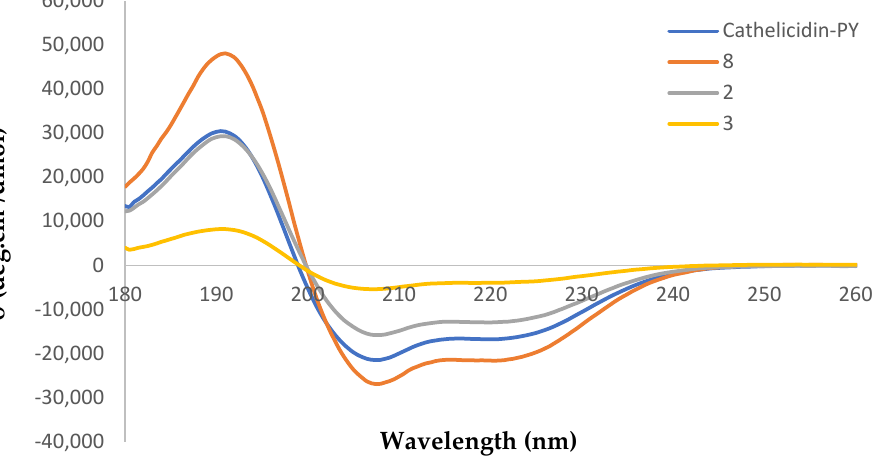
Figure 5. Circular dichroism (CD) spectra carried out in membrane-mimetic environments (TFE:H 2 O, 1:1, v/v ) for cathelicidin − PY and associated analogues, 2 , 3 , and 8 , depicting an α− helical secondary structure. CD spectra were collected at 25 °C with peptides dissolved at 0.2 mM.